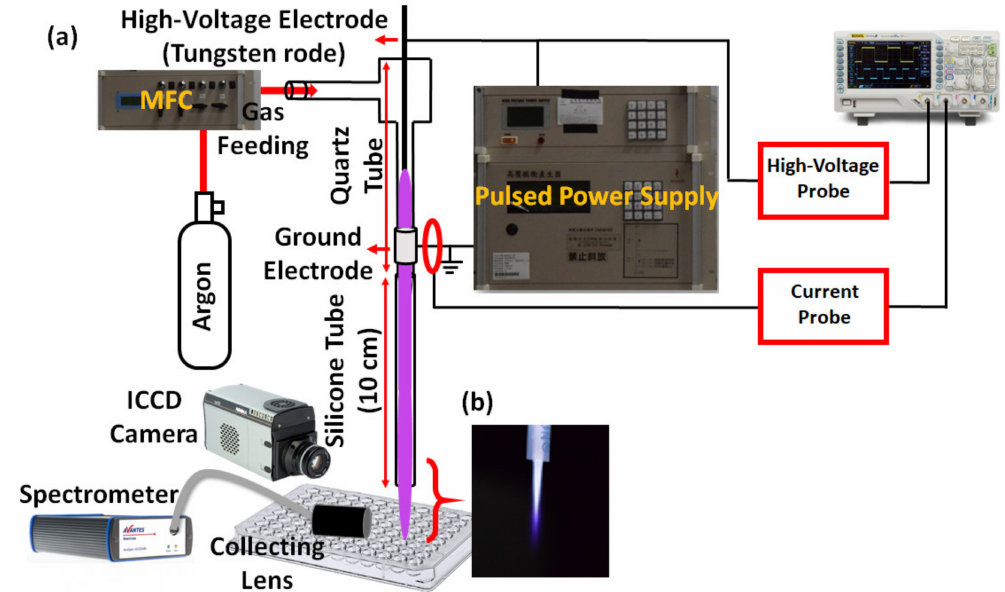
Figure 1. ( a ) Experimental setup of the transferred argon plasma jet system including an ICCD camera for emission characterization and spectrometer for spectroscopic characterization. ( b ) Image of the transferred cold atmospheric plasma (CAP) including argon